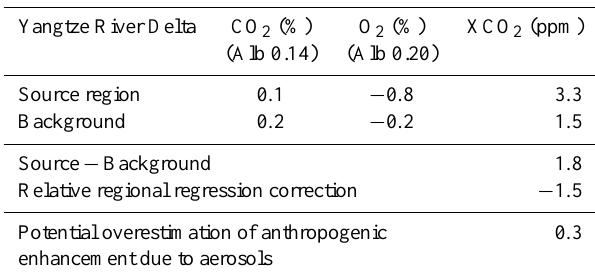
Table 1. Evaluation of the potential overestimation of the retrieved regional anthropogenic XCO 2 enhancement due to aerosols in the case of the Yangtze River Delta based on simulated measurements. In the radiative transfer simulations the aerosol profiles shown in Fig. 5, which are consistent with GEMS AOD, and the averaged retrieved albedos for the source and background region are used to estimate the resulting percentual CO 2 and O 2 column errors. The calculations are performed for a solar zenith angle of 30 ◦ , which is approximately the mean value in both regions.